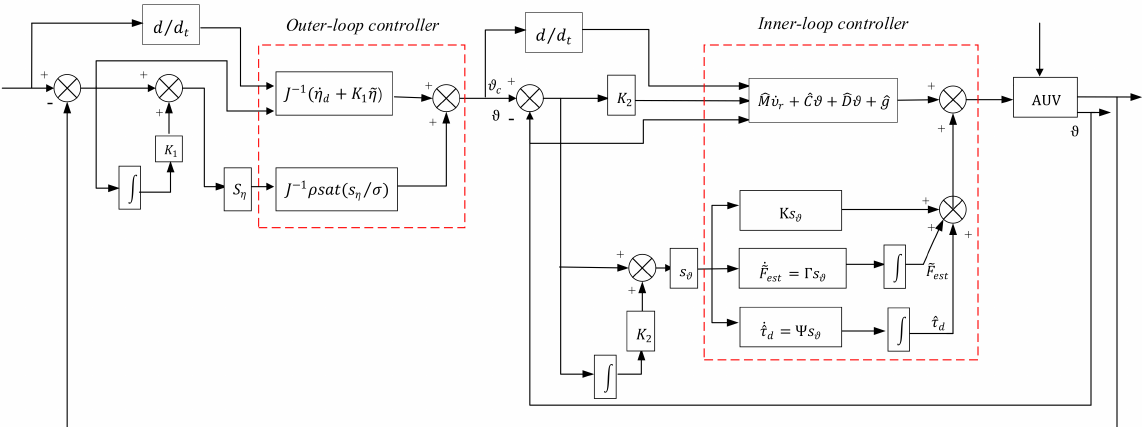
Figure 7. Block diagram for the double-loop chattering-free adaptive integral sliding mode control scheme (Reprinted from reference [97] with permission from Elsevier, copyright